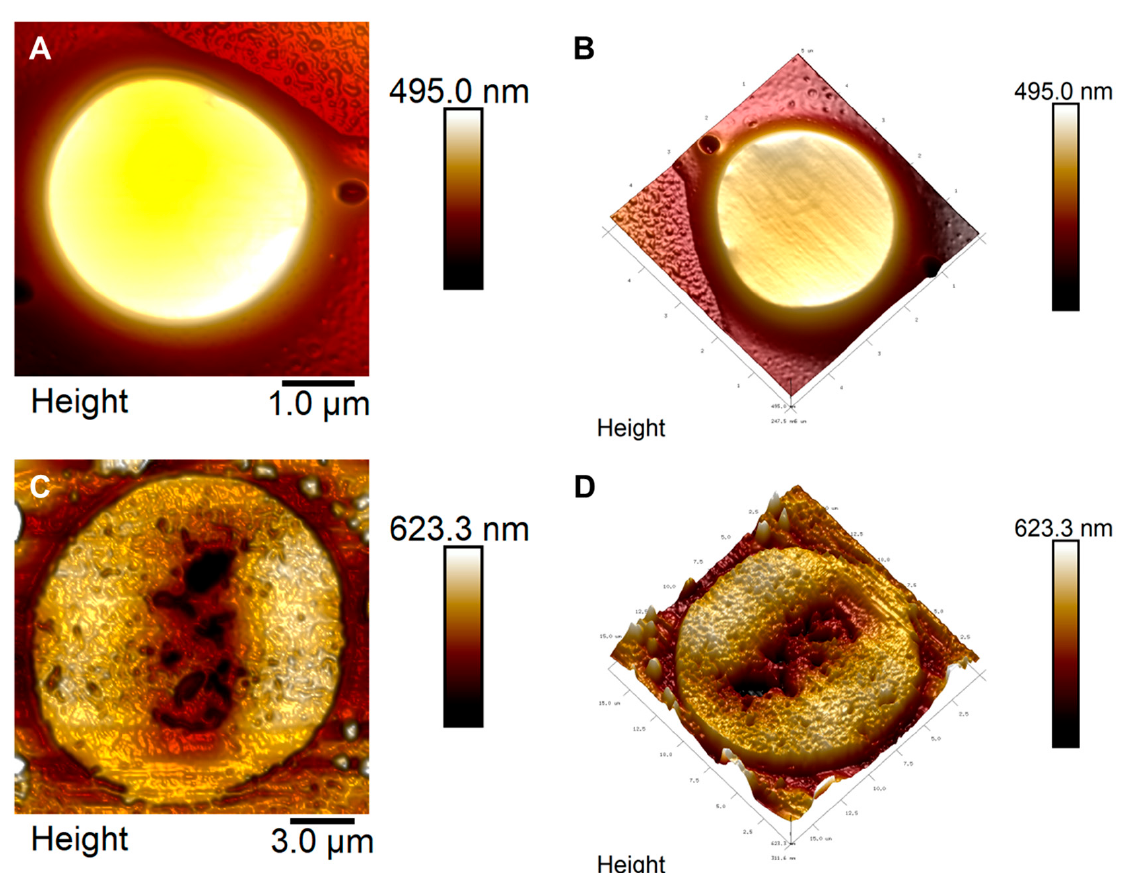
Figure 5. Atomic force microscopy (AFM) images showing damage in C. neoformans cells induced by Mo -CBP 3 -PepII. ( A , B ) Control cell of C. neoformans treated with DMSO. ( C , D ) The cell of C. neoformans treated with Mo-CBP3-PepII.